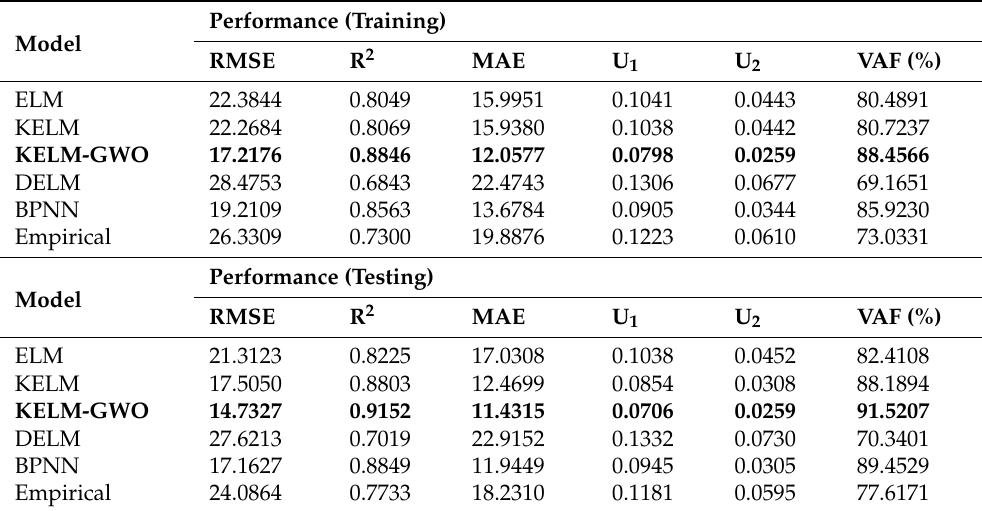
Table 5. Comparison of the performances of all models (training